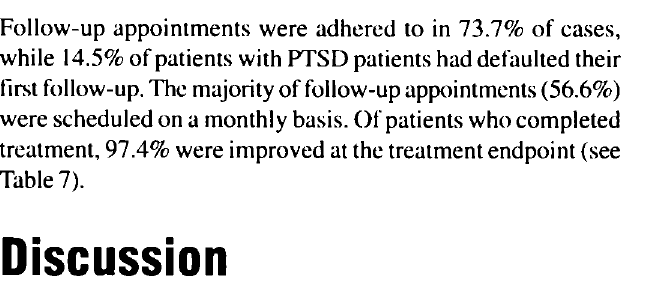
Type of medication